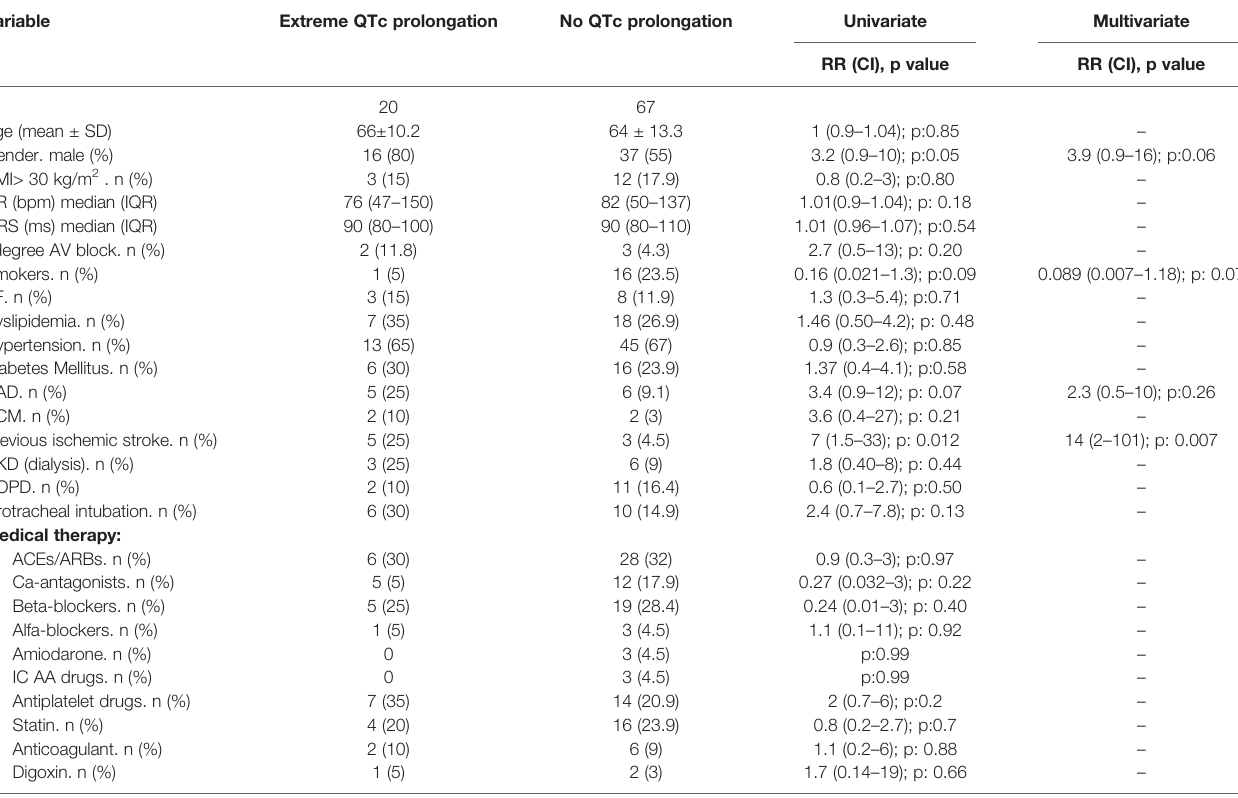
TABLE 2 | Distribution of patients ’ characteristics and their association with extreme corrected QT (QTc) prolongation among COVID-19 study population.